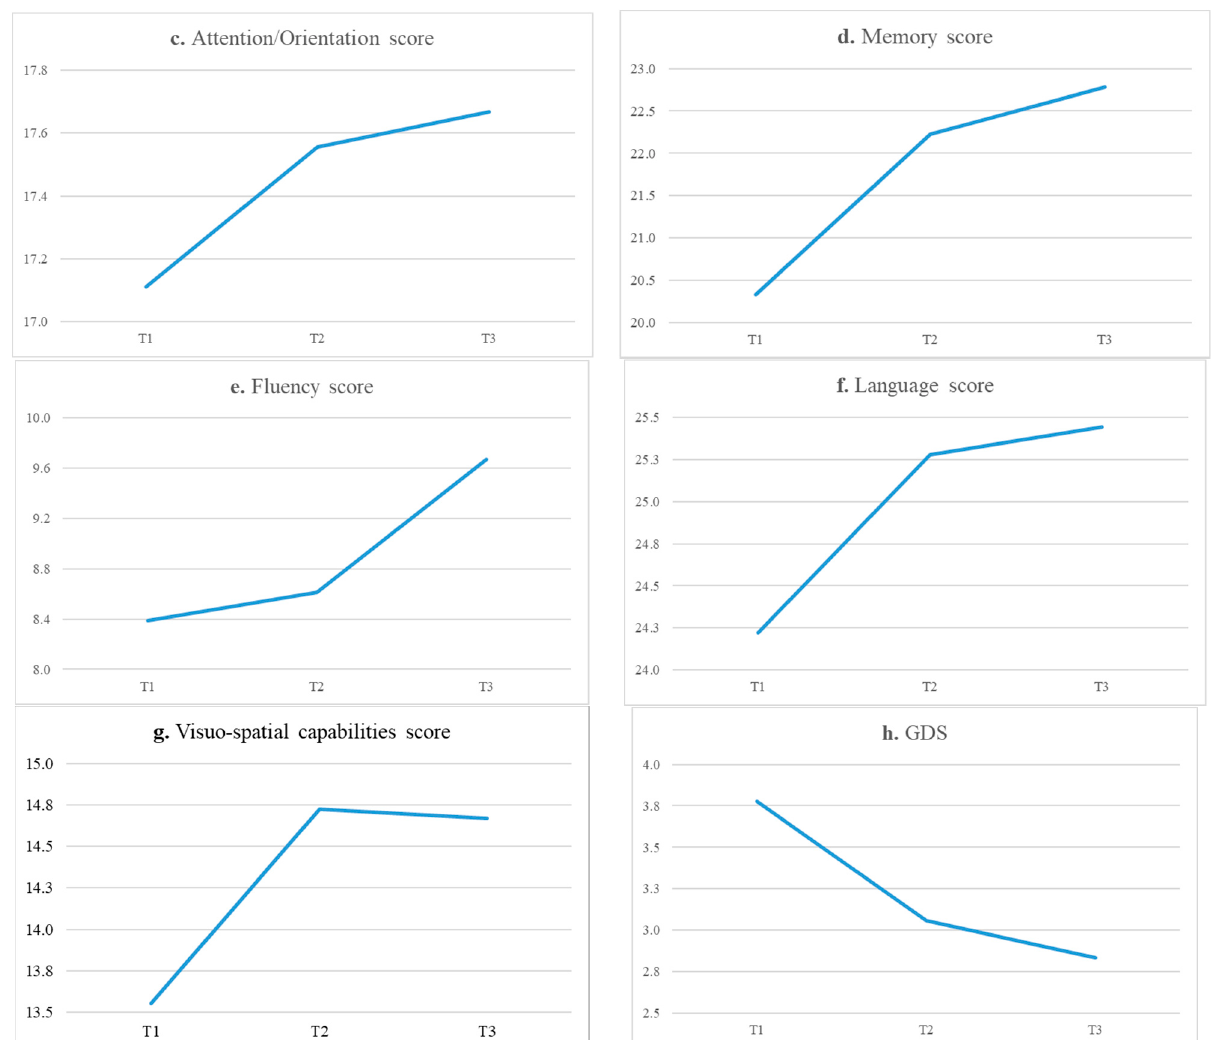
Figure 2. Quantitative results (Key: T0 baseline assessment, pre-COVID-19, T1 after about 8 months, without treatment, T2 after the intensive treatment, 14 twice-weekly group sessions). Table 3. Code and sub-codes of the qualitative contents’ analysis per